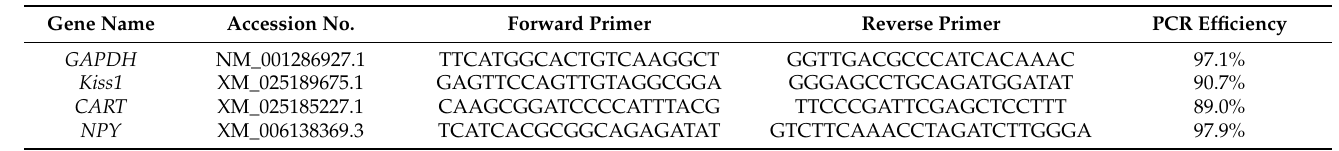
Table 1. Gene name, GenBank accession number, forward and reverse primer sequences, and real-time PCR efficiency for target genes